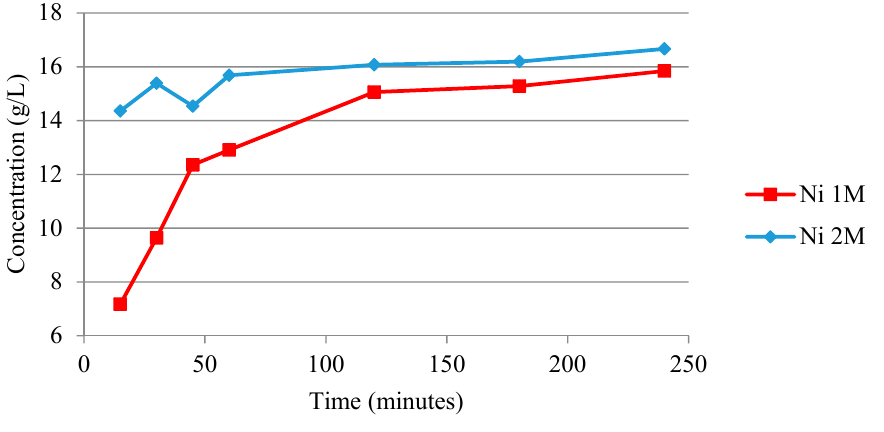
Figure 7. Leaching of nickel from cathode material with 1 mol/L and 2 mol/L hydrochloric acid at 25 °C .